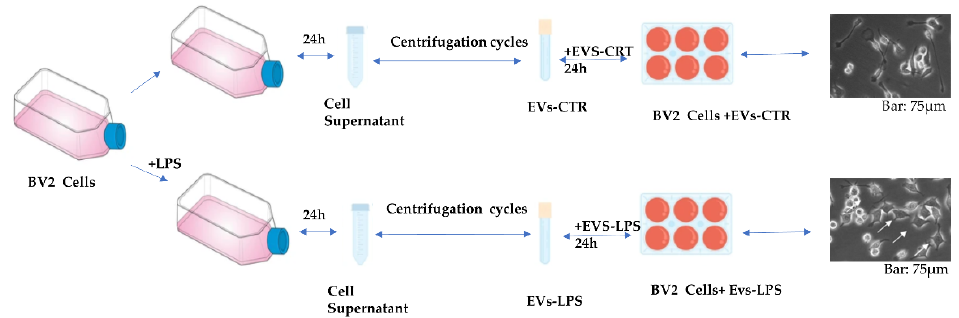
Figure 1. Schematic representation of EVs production without (EVs-CTR) and with LPS (EVs-LPS) stimulation of BV2 cells. stimulation of BV2